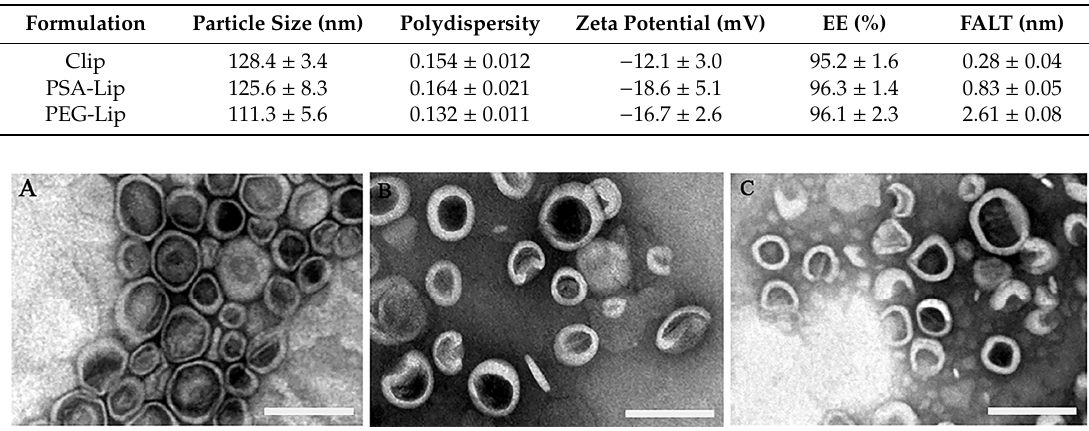
Figure 1. The TEM images of ( A ) Clip, ( B ) PSA-Lip, and ( C ) PEG-lip. Scale bars represented 200 nm.